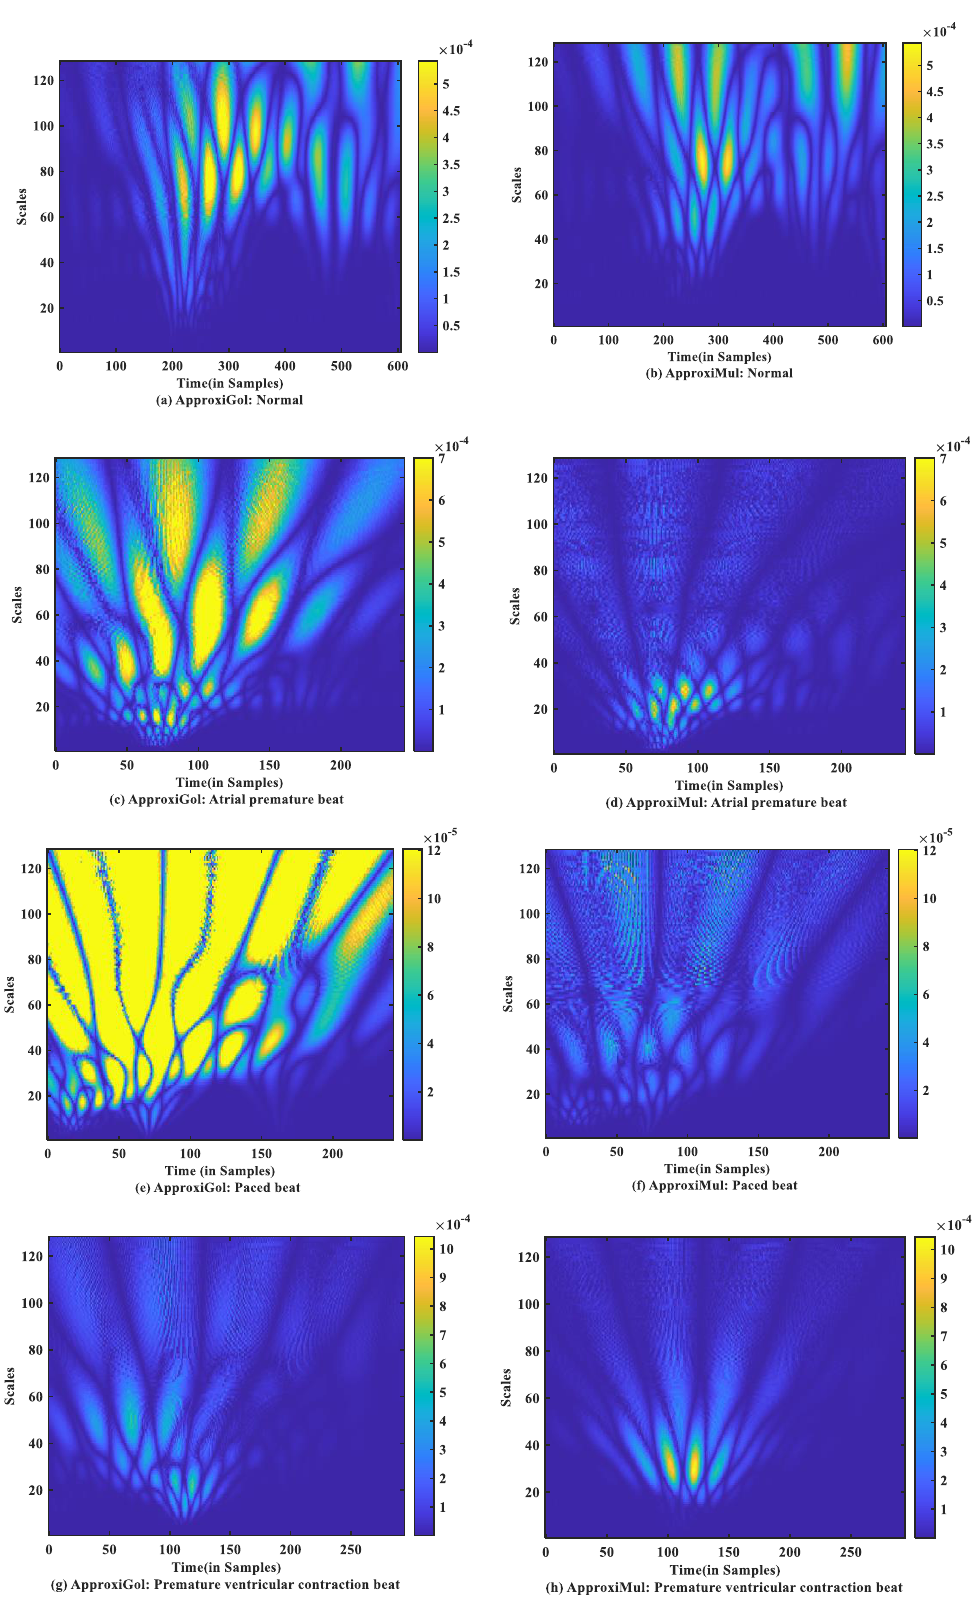
Figure 9. Absolute scalogram difference of different types of ECG beats representing physiological or pathophysiological conditions using ApproxiGlo and ApproxiMul methods.